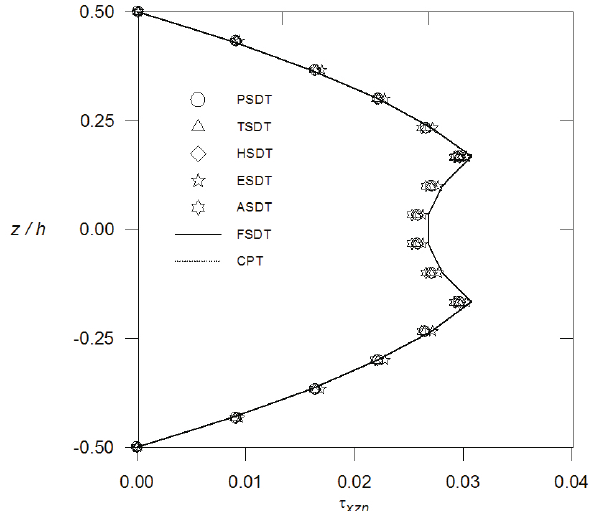
Figure 8: Variation of normalized transverse shear stress τ xz across the thickness for three layered (0 ∘ /90 ∘ /0 ∘ ) symmetric laminated composite square plate for aspect ratio